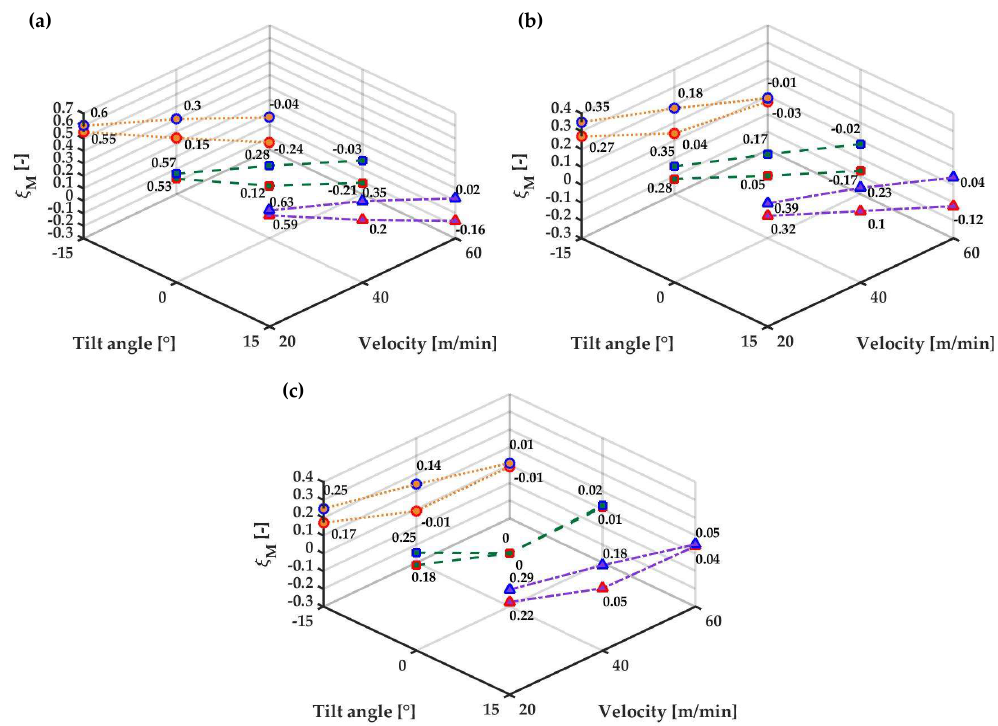
Figure 10. Mass sealing effectiveness coefficient at section γ for AC mass flow ( a ) 3%; ( b ) 5%; ( c ) 7%.